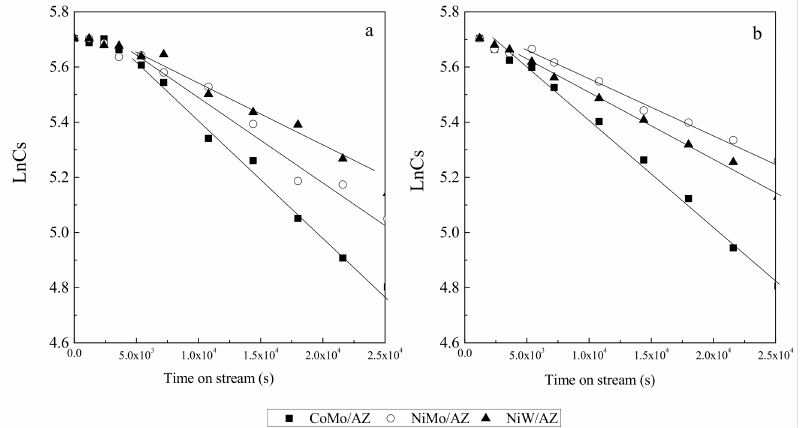
Figure 9. The effects of nitrogen introduction on Ln(C s ) with time on stream (Reaction conditions: 648 K, 8.96 MPa, 1000 rpm, 20 g catalyst, 200 g feed (4,6-DMDBT with 300 ppm sulfur, carbazole with 300 ppm nitrogen, 20 w% 1-MN in Hexadecane). ( a ) before the Nitrogen introduction; ( b ) after the Nitrogen introduction.